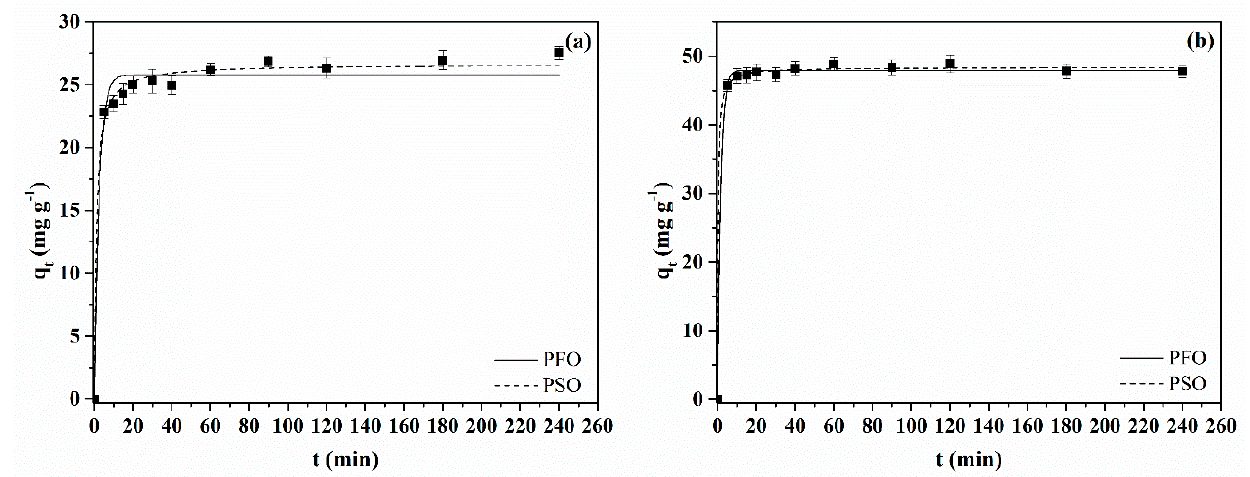
Figure 7. The kinetic curve of BB dye adsorption onto ( a ) MAC1105 and ( b ) MAC111. The experimental kinetic data were fitted to the pseudo-first-order (PFO) and pseudo-